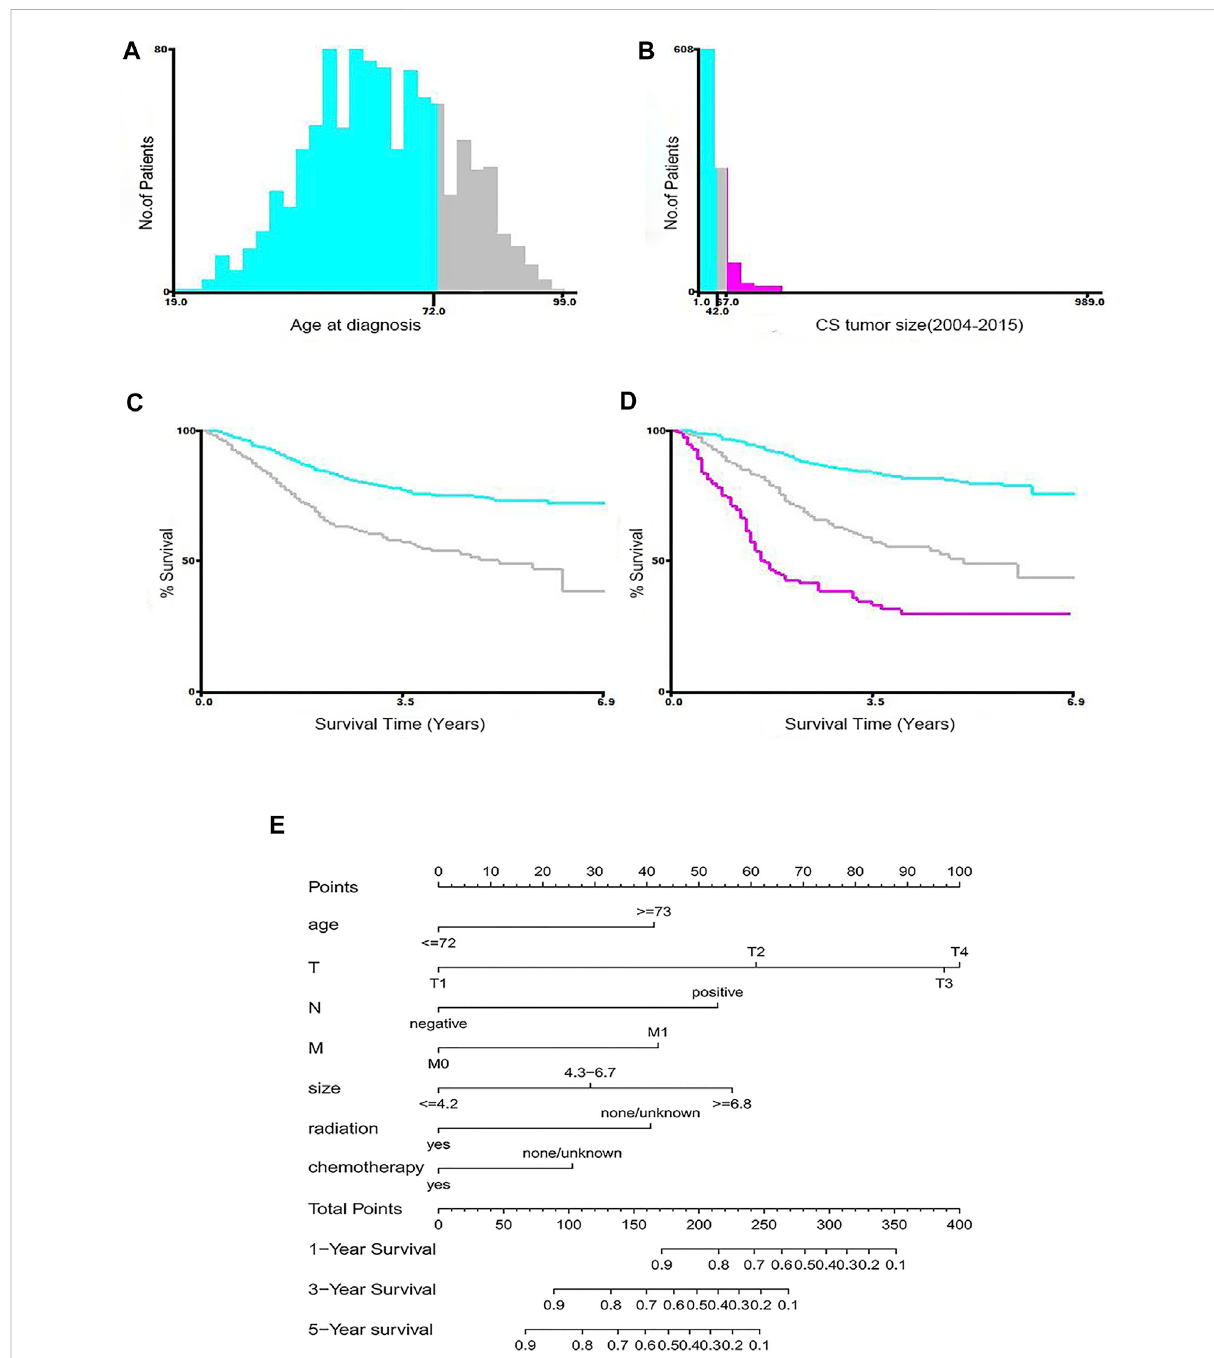
FIGURE 2 Identi fi cationofoptimalcut-offvaluesforage (A,C) andtumorsize (B,D) byX-tilesoftwareanalysis.Theoptimalcut-offvalueofageisidenti fi ed as 72-years, and the cut-off for tumor size is identi fi ed as 4.2, 6.7 cm based on entire cohort. Nomograms for predicting the 1-, 3-, and 5-years OS rates of patients with MBC (E)